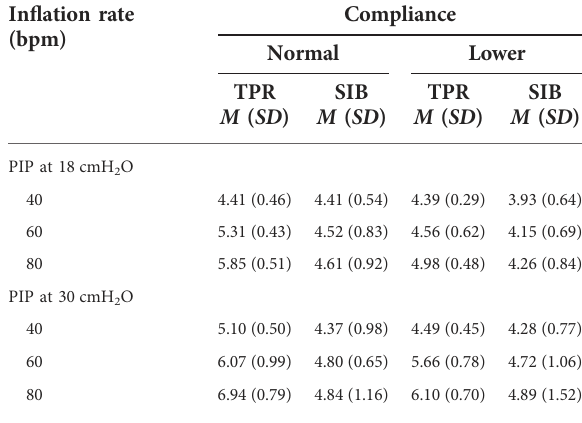
TABLE 1 Mean (SD) PEEP (cmH 2 O) at PIP of 18 and 30 cmH 2 O with normal and lower lung